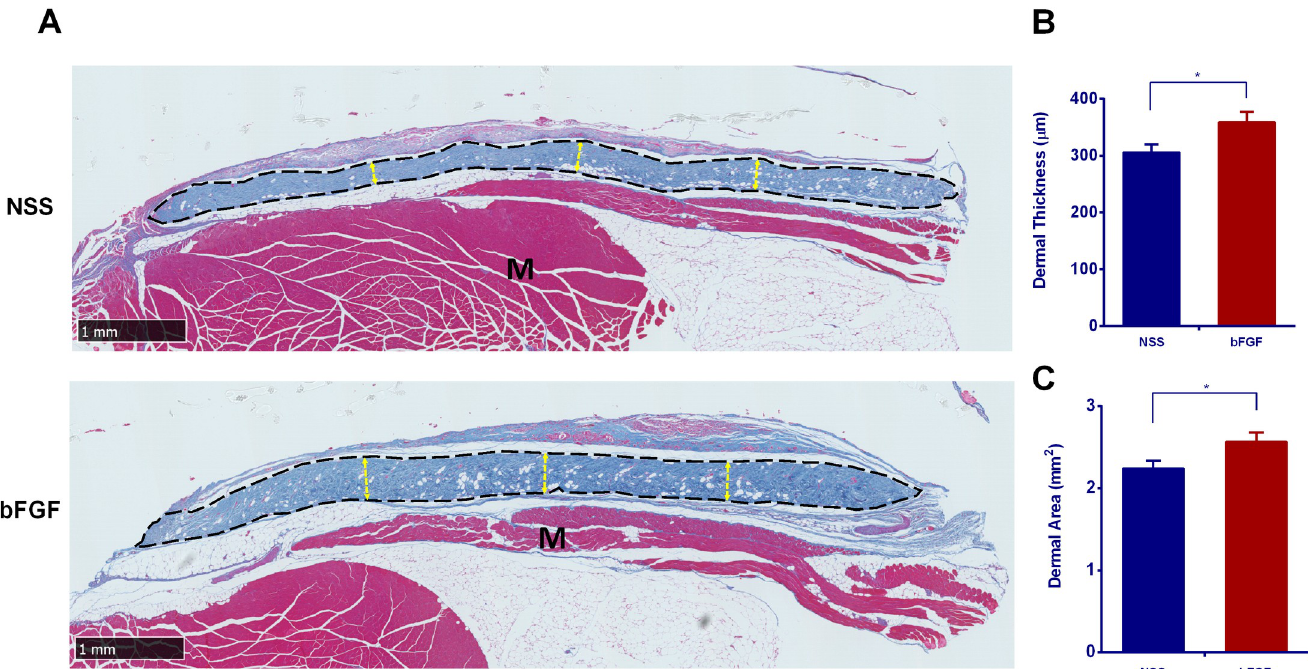
Fig 6. The assessment of dermal thickness and area after 8 weeks implantation. (A) A micrograph of the Azan staining at Week 8. The areas of the grafts are indicated by broken black lines. No signs of infection or necrosis were observed in either group. The yellow broken line indicates the evaluated thickness of the grafts, M: recipients’ muscle; Magnification: 2x, scale bar: 1 mm. (B) A comparison of the thickness of the grafts between the two groups at Week 8. The grafts in the bFGF group were significantly thicker than those in the NSS group ( � p < 0.05). (C) A comparison of the area of the grafts between the two groups at Week 8. The dermis of the bFGF group was significantly larger than that in the NSS group ( � p <